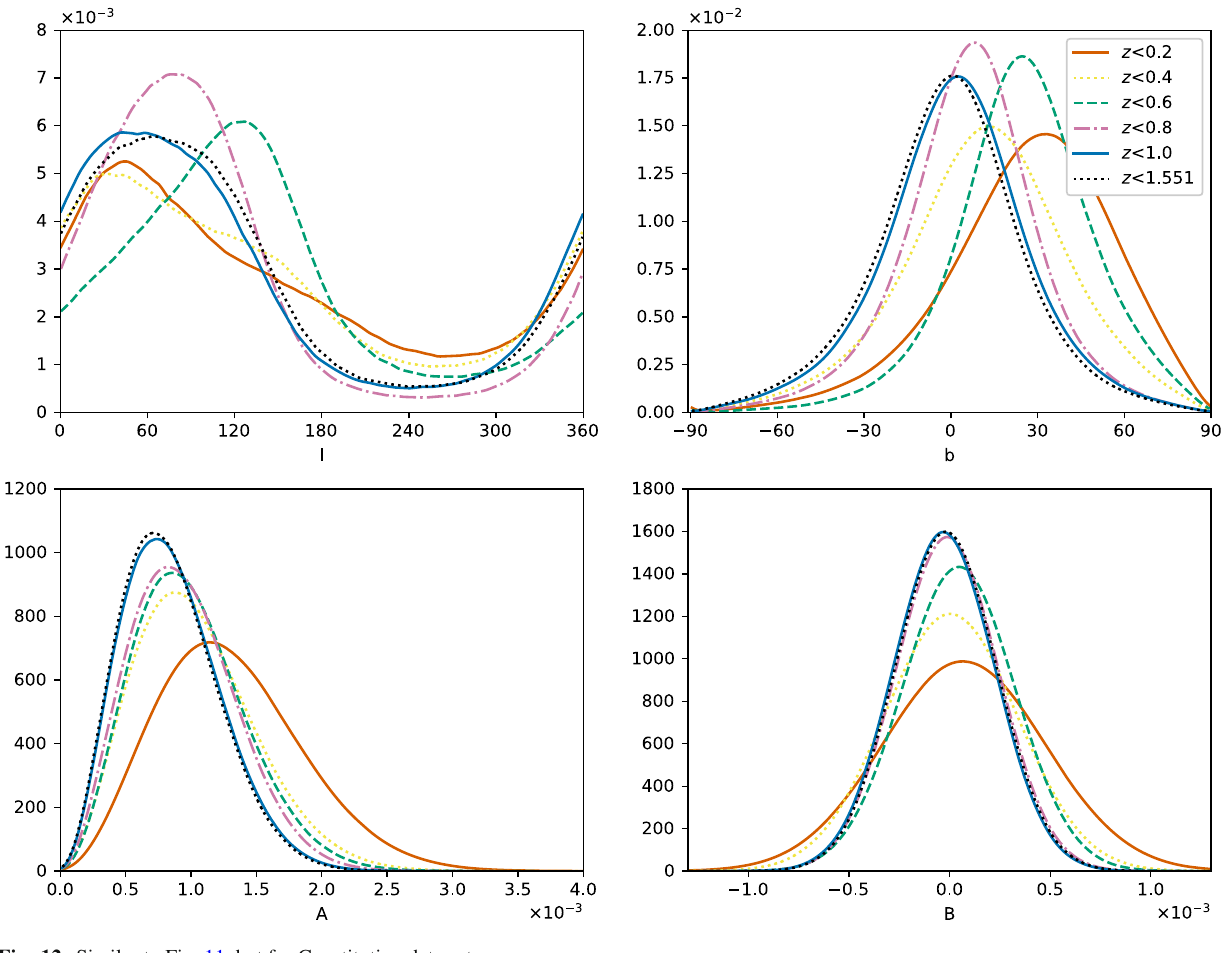
Fig. 12 Similar to Fig. 11, but for Constitution data set